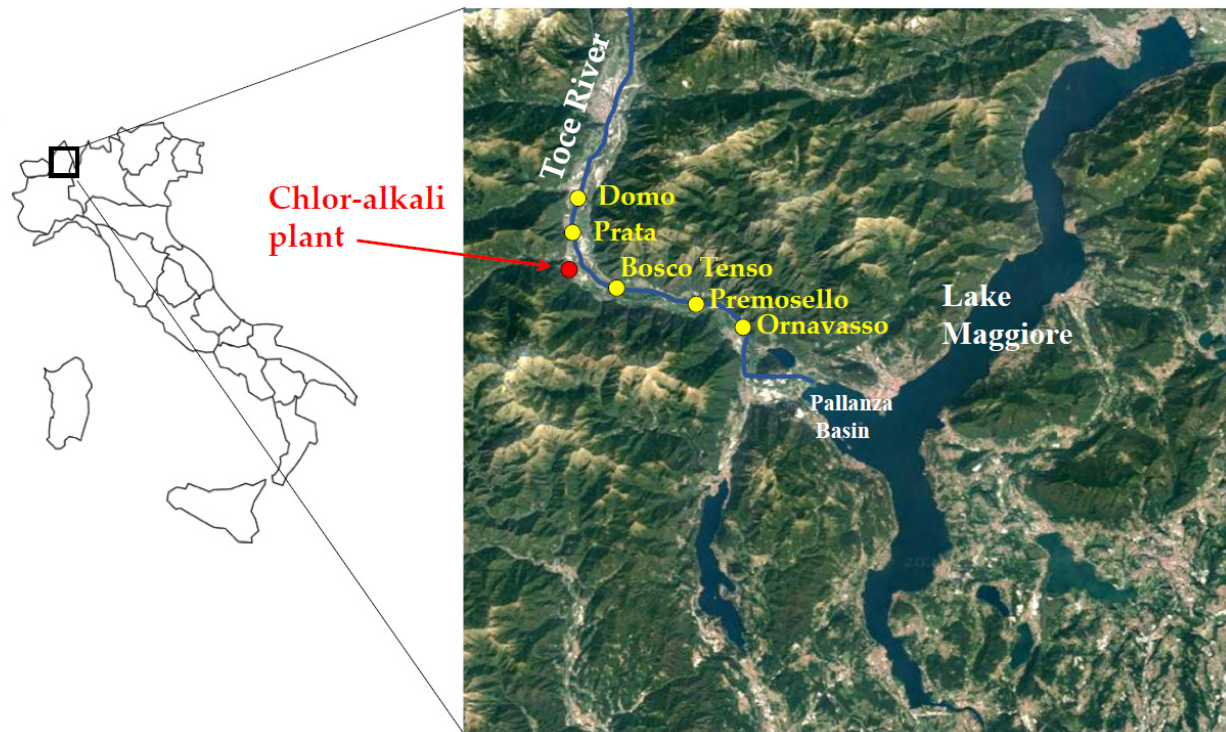
Figure 1. Map of the study area. Sampling points and the location of the chlor-alkali plant along the Toce River (Piedmont Region, Northern Italy) are reported.